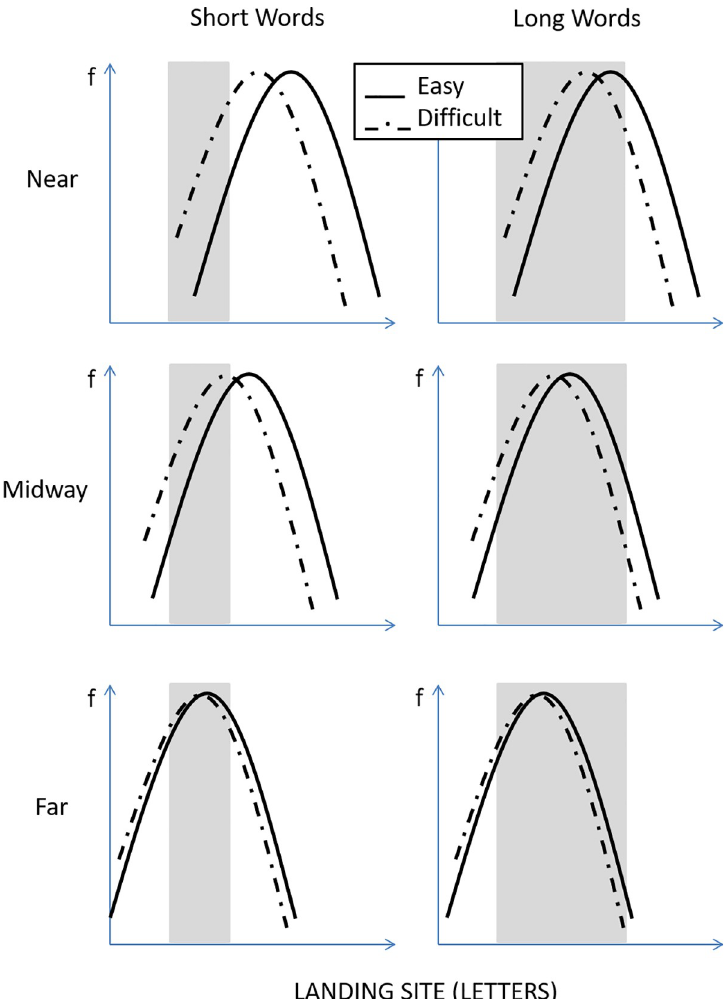
Fig 1. Illustration of the predictions made by the bottom-up, non-word-based, CoG hypothesis. Under this assumption, saccade amplitudes should be overall modulated by word-processing difficulties regardless of word boundaries, but to greater extents for shorter and less eccentric words, that more greatly benefit from peripheral preview. Are represented the hypothetical frequency distributions of saccades’ landing positions on the line of text for easy (plain lines) vs. difficult (dotted lines) peripheral words (N+1), separately for short and long words (left and right panels), and close, intermediate, and far saccadic launch-site distances to the beginning of the words (from upper to lower panels). Light-grey rectangle areas represent the horizontal extent of the words. Landing positions falling within those areas correspond to within-word landing positions, while landing positions to the right of these areas result in word